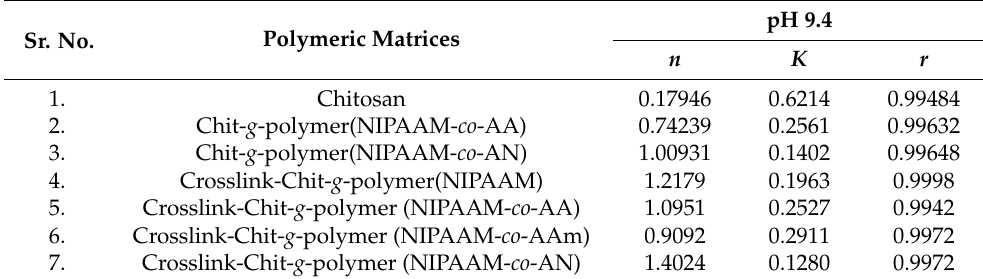
Table 3. DS Release Kinetic study of Grafted Copolymers of NIPAAM and Crosslinked-graft Copolymers a of NIPAAM and Binary Comonomers onto Chitosan.